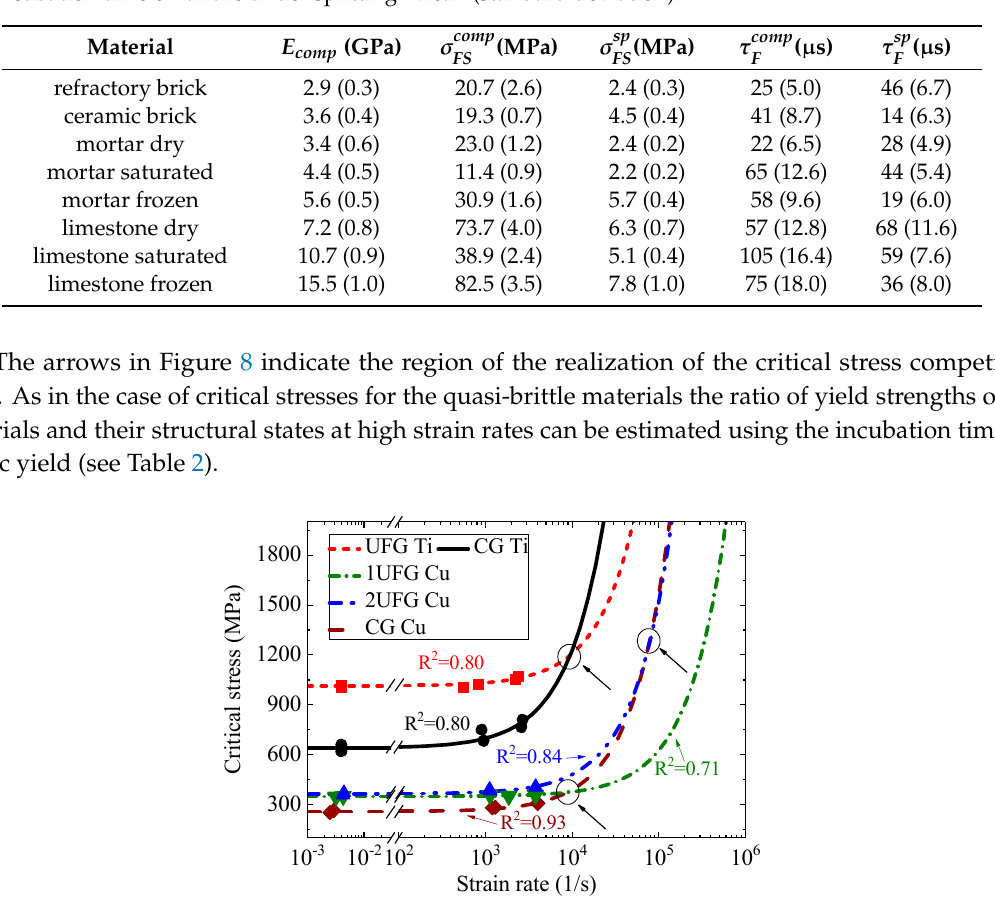
is the quasi-static compression strength; σ sp FS F